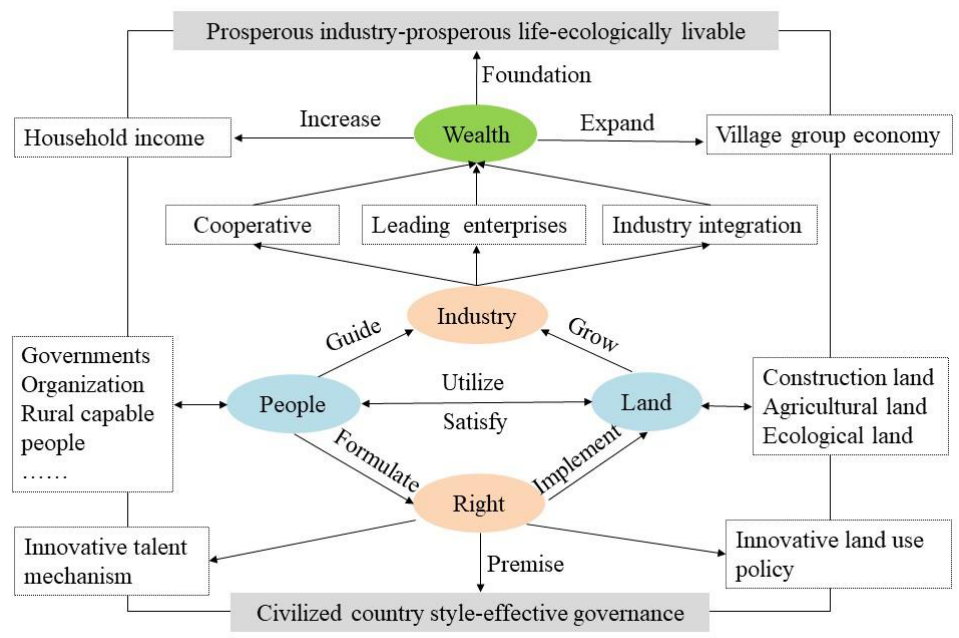
Figure 1. Mechanisms of rural revitalization in the perspective of people-land-industry-wealth- right.